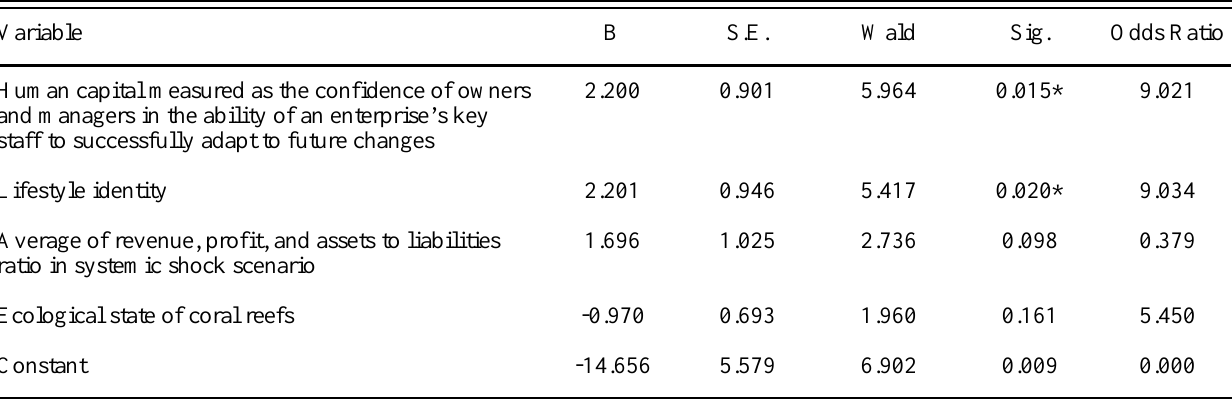
Table 6. Logistic regression analysis of the explanatory variables for enterprise resilience (Corrected Akaike’s Information Criterion score = 39.67).